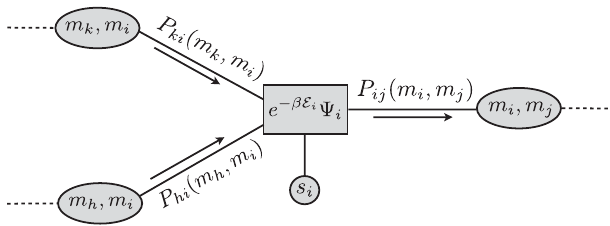
displayed.FIG. 4. Factor-graph representation of the BP equations for the optimal immunization problem in the SIS model. Variable nodes are of two types: One type includes pairs of auxiliary variables fð m i ; m j Þg ; the other includes the immunization variables f s i g . There is a factor node for each node i of the original graph, including the energetic term E i and the hard constraint Ψ i